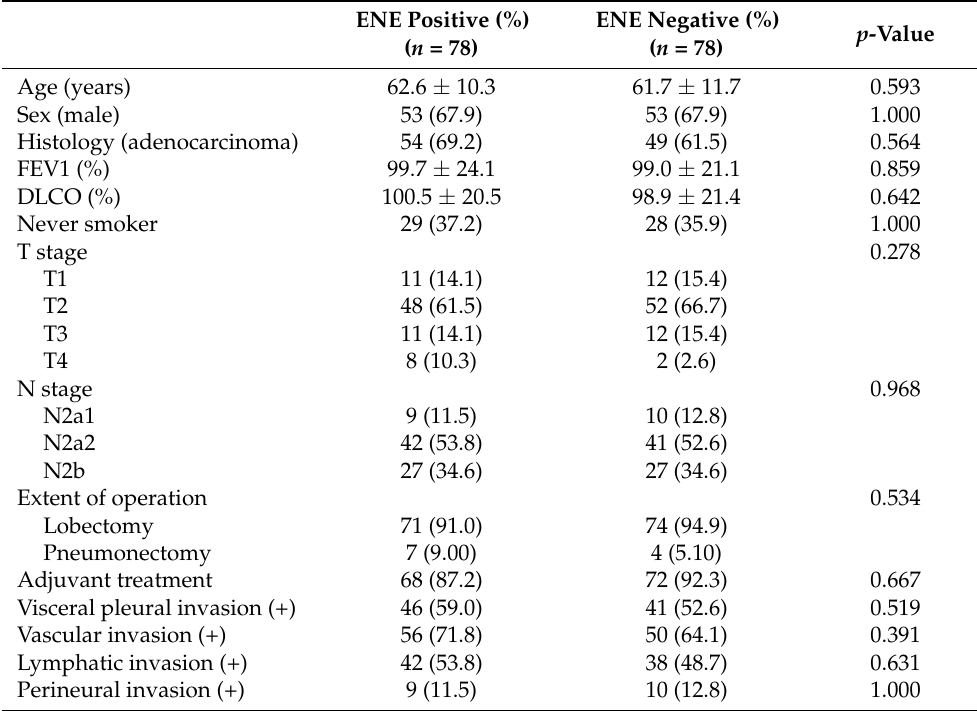
Table 3. Clinical characteristics of patients depending on the status of extranodal extension after propensity score matching.